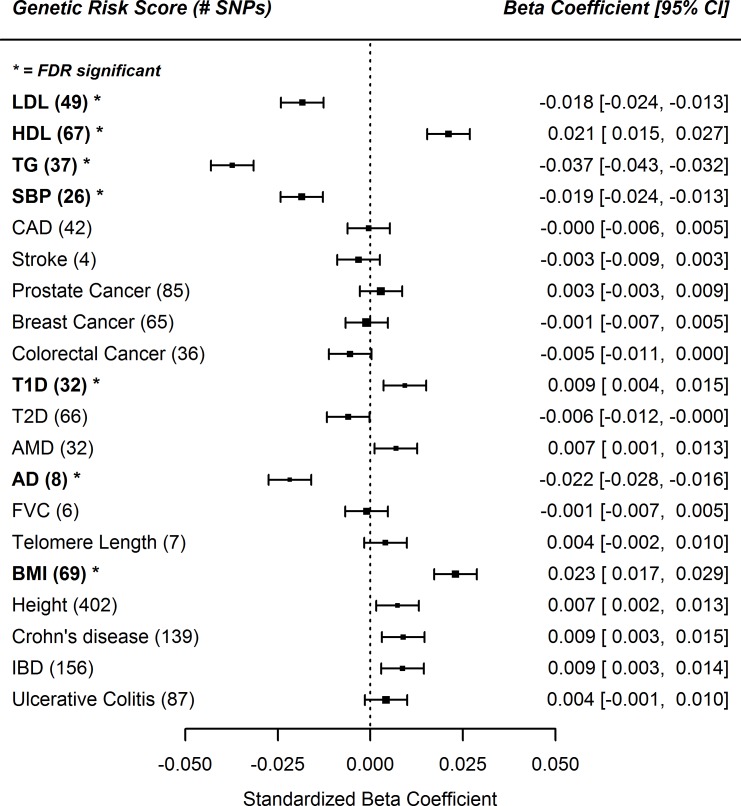
Genetic Risk Score associations with RDW.* FDR = false-discovery rate adjusted significant association. Genetic Risk Scores (GRS) were z-transformed prior to analysis. Linear regression model against RDW (z-transformed) including 116,666 participants, adjusted for age, sex, assessment center and population structure (genetic PCs 1–5). LDL (low-density lipoprotein), HDL (high-density lipoprotein), TG (triglycerides), SBP (systolic blood pressure), CAD (coronary artery disease), T1D (type-1 diabetes), T2D (type-2 diabetes), AMD (age-related macular degeneration), AD (Alzheimer’s disease), FVC (forced vital capacity), BMI (body mass index), IBD (inflammatory bowel disease). Full results in S6 Table.